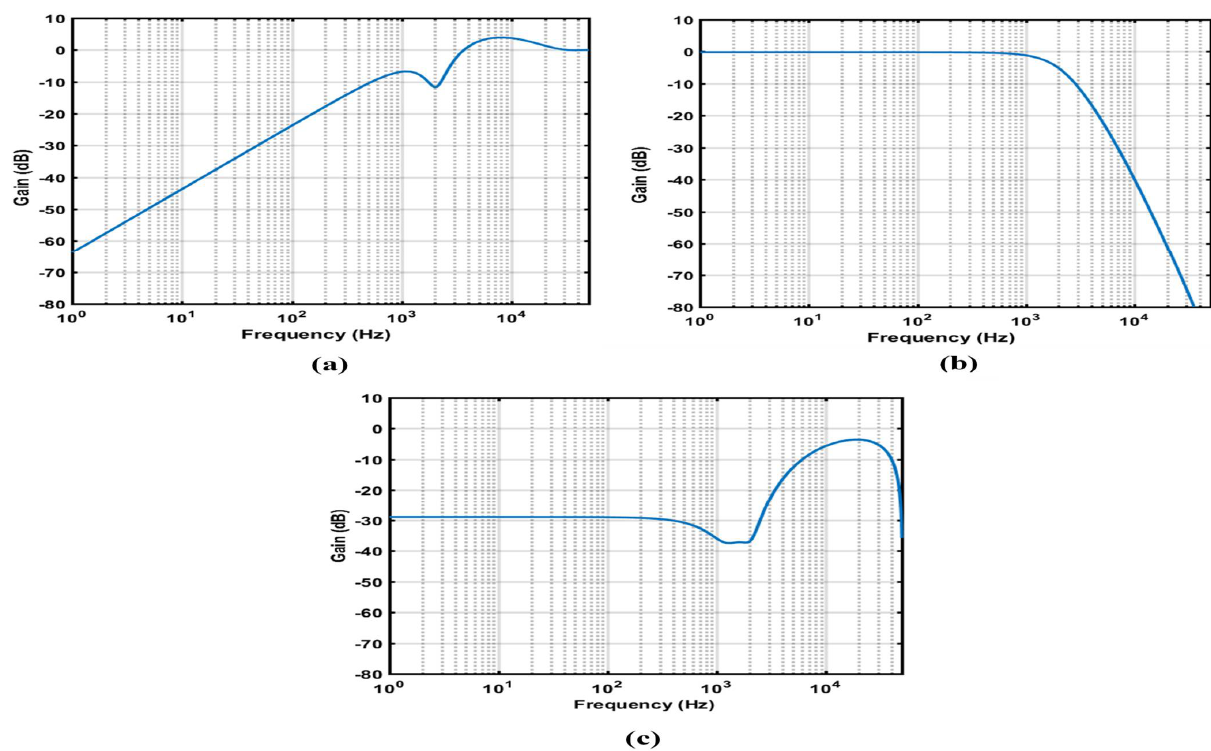
Figure 6. ( a ) Output sensitivity ( S 0 ), ( b ) Complementary sensitivity ( T 0 ) , ( c ) Input sensitivity ( S i ) .